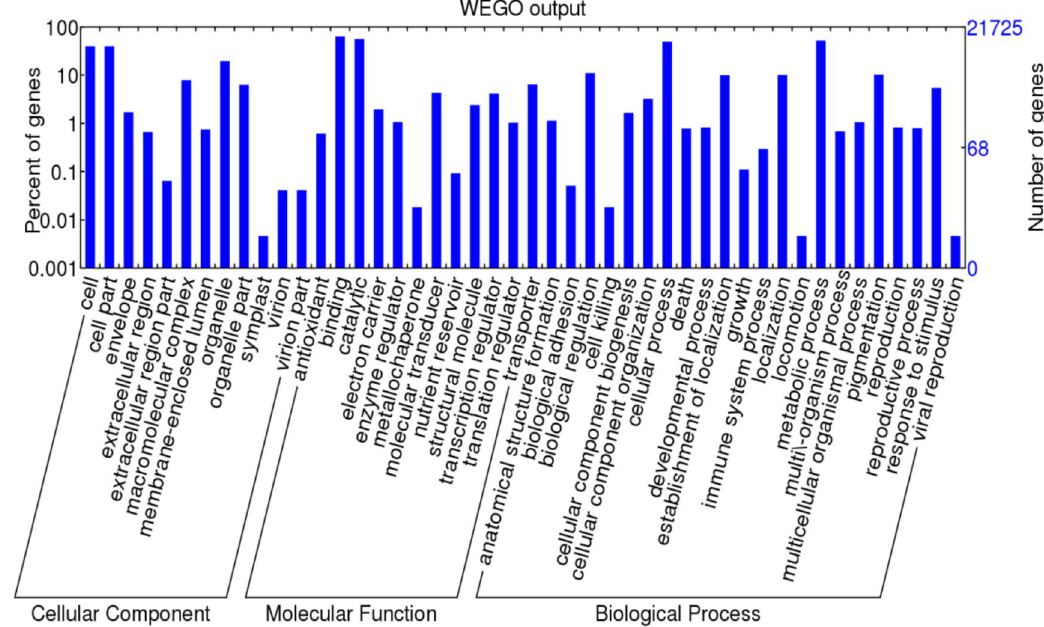
Figure 3. GO classification for the H.brasiliensis bark transcriptome.